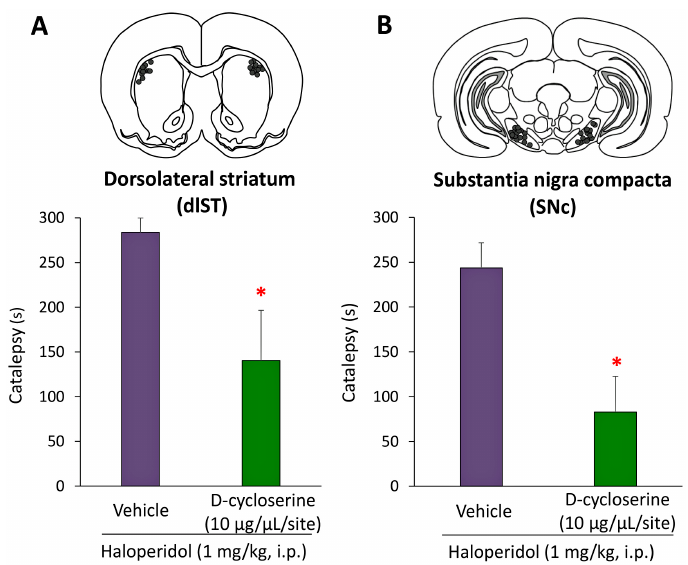
Figure 4. Effects of intranigral and intrastriatal microinjections of D -cycloserine (DCS) on haloperidol (HAL)-induced catalepsy in rats. ( A , B ) The effects of DCS (10 μ g/1 μ L/side) microinjected into the substantia nigra compacta (SNc) or dorsolateral striatum (dlST) against HAL-induced catalepsy were examined. Each dose of HAL was administered 15 min after each DCS microinjection and, 30 min later (45 min after the DCS microinjection), the catalepsy time was measured. Schematic drawings of a rat brain section illustrating DCS or vehicle injection sites (filled circles) in the SNc ( A ) or dlST ( B ) are shown at the top. Each column represents the mean ± S.E.M. of 6–11 rats. These data were analyzed by the Mann-Whitney U -test. * p < 0.05, significantly different from the control value with vehicle + HAL.